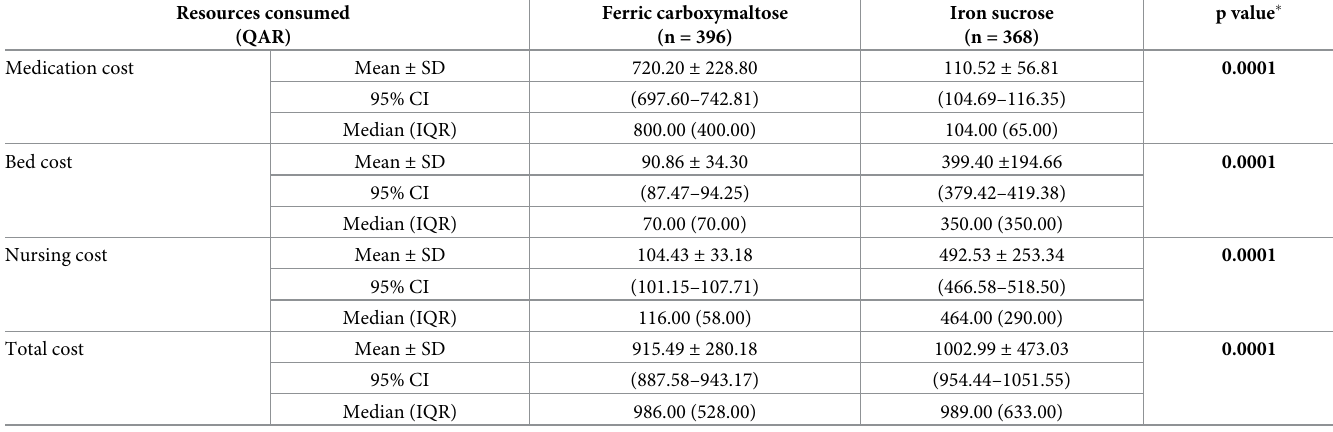
Table 4. Comparison of resource expenditures between patients in the two treatment arms.